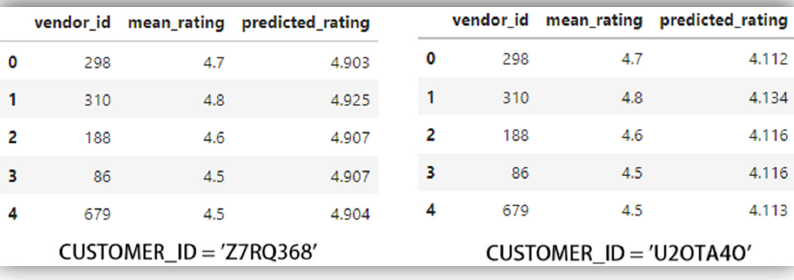
Figure 37. Recommend 5 restaurants for customer ratings.